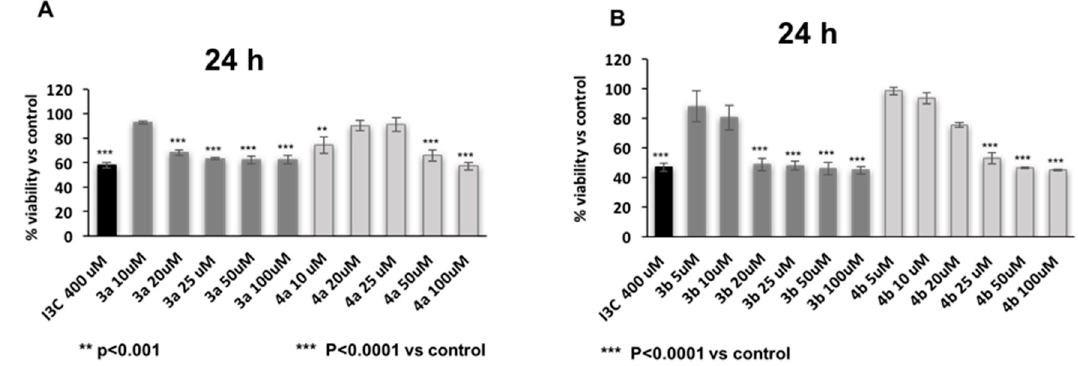
Figure 3. Effect of 400 µM I3C and increasing concentrations of the indole derivatives ( A ) 3a , 4a and ( B ) 3b , 4b on FaO cell viability, determined by neutral red uptake (NRU) assay after 24 h of treatment. Data are expressed as percentage of viable cells assessed by neutral red.